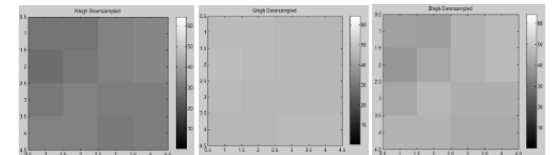
Figure 5c. Projected 16 × 16 pixels for blue channel For the second case, downsampling of projected high resolution multispectral data (shown in Figures 5a- 5c) for the three bands is shown in figure 6.